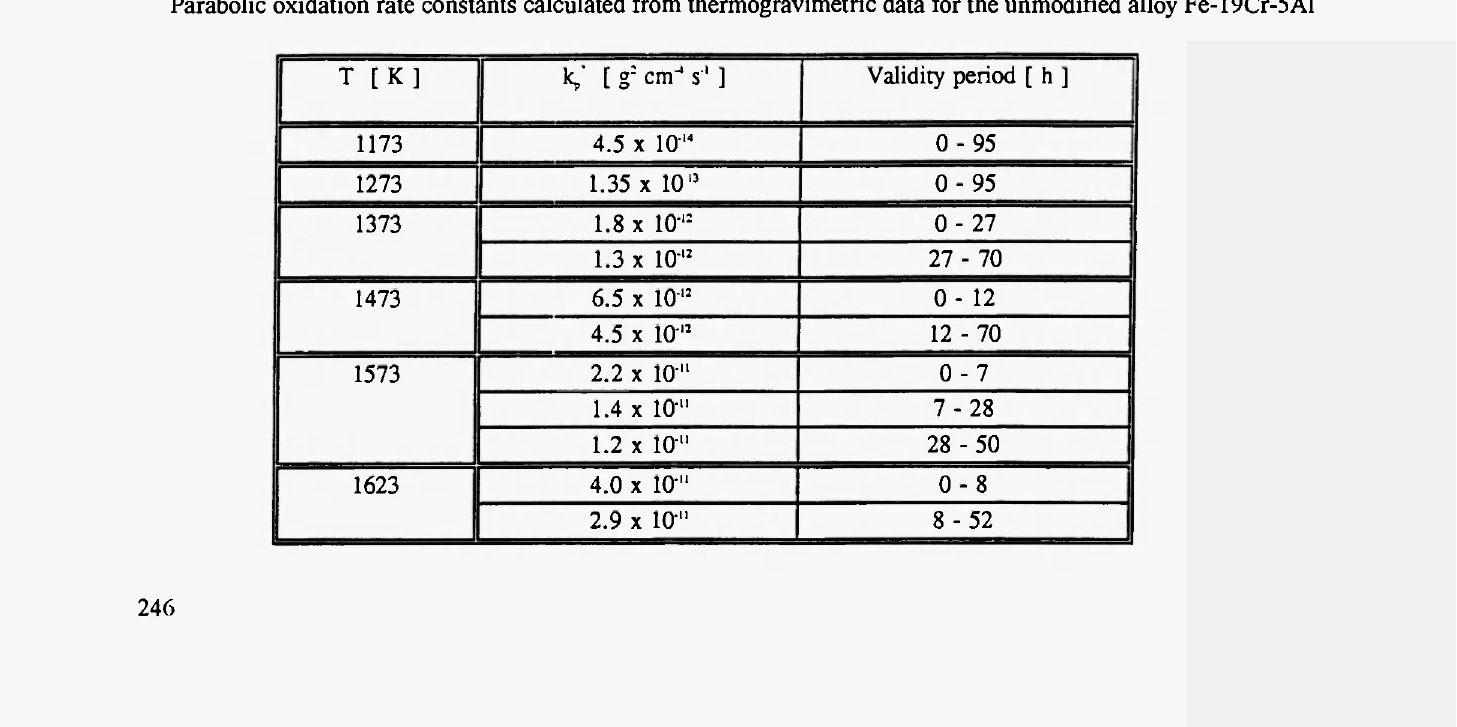
Parabolic oxidation rate constants calculated from thermogravimetric data for the unmodified alloy